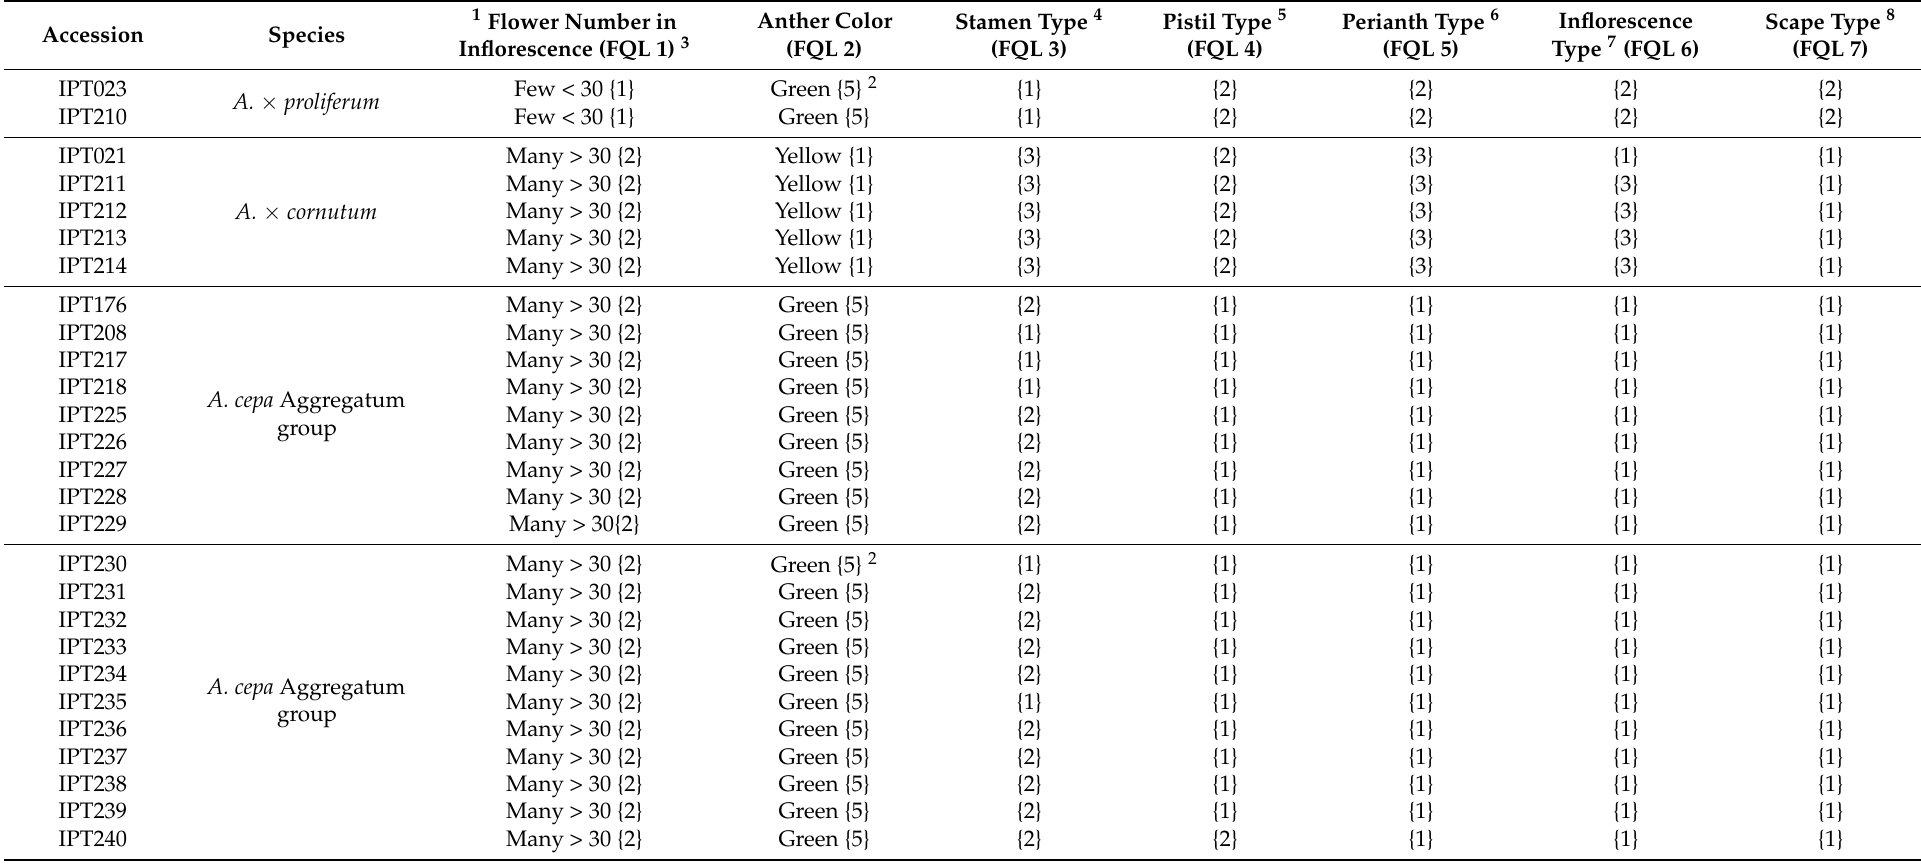
Table 2. Qualitative generative shallot morphology descriptors for 32 flowering